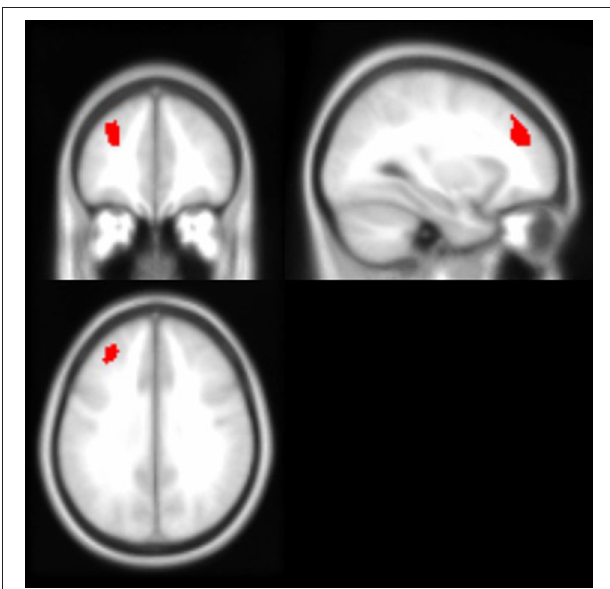
FIGURE 2 | Brain images depicting the gray matter region in which non-Hispanic/Latino Whites had larger gray matter volumes compared to Hispanics/Latinos, controlling for age and intracranial volume ( p < 0.001, k > 50). This region (in red) is in the left middle frontal gyrus; Montreal Neurological Institute (MNI) coordinates: − 30, 40, 32.